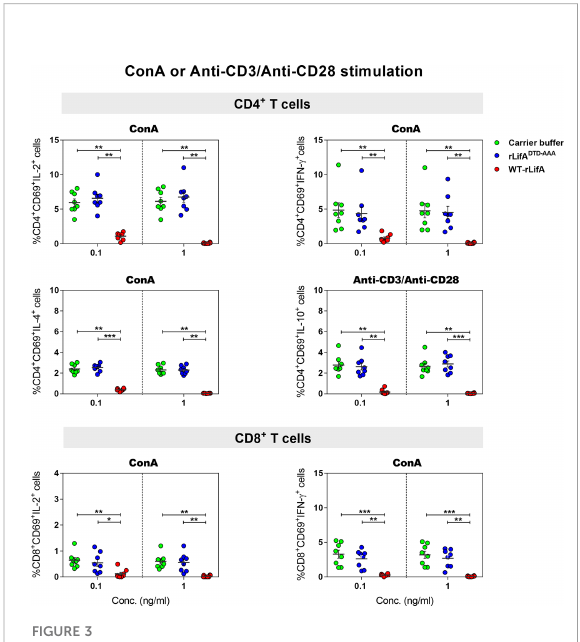
FIGURE 3 Lymphostatin inhibits intracellular cytokine production in anti- CD3/anti-CD28 or ConA-stimulated CD4 + and CD8 + T cells. Dot plots show the percentage of CD4 + /CD69 + cells producing IL-2, IFN- g , IL-4, IL-10 and CD8 + /CD69 + cells producing IL-2, IFN- g in the presence of WT-rLifA, rLifA DTD-AAA , or carrier buffer. Data represent the mean from 8 healthy donors ± S.E.M. * p < 0.05, ** p < 0.01, *** p < 0.001 using Kruskal-Wallis test followed by Dunn ’ s